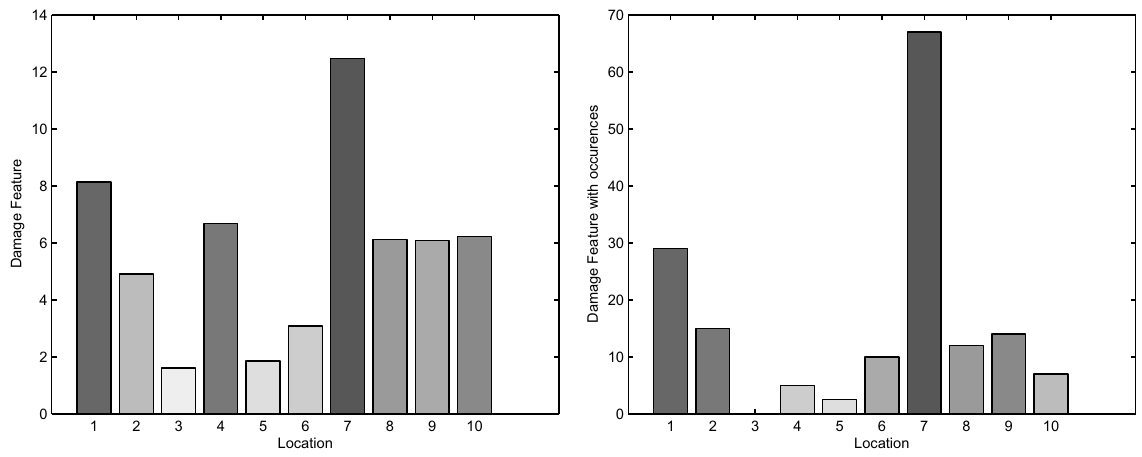
Fig. 31. Damage feature without and with occurrences for damaged structure and constant loading conditions (force applied in DOF 1), frequency range 10–30Hz.